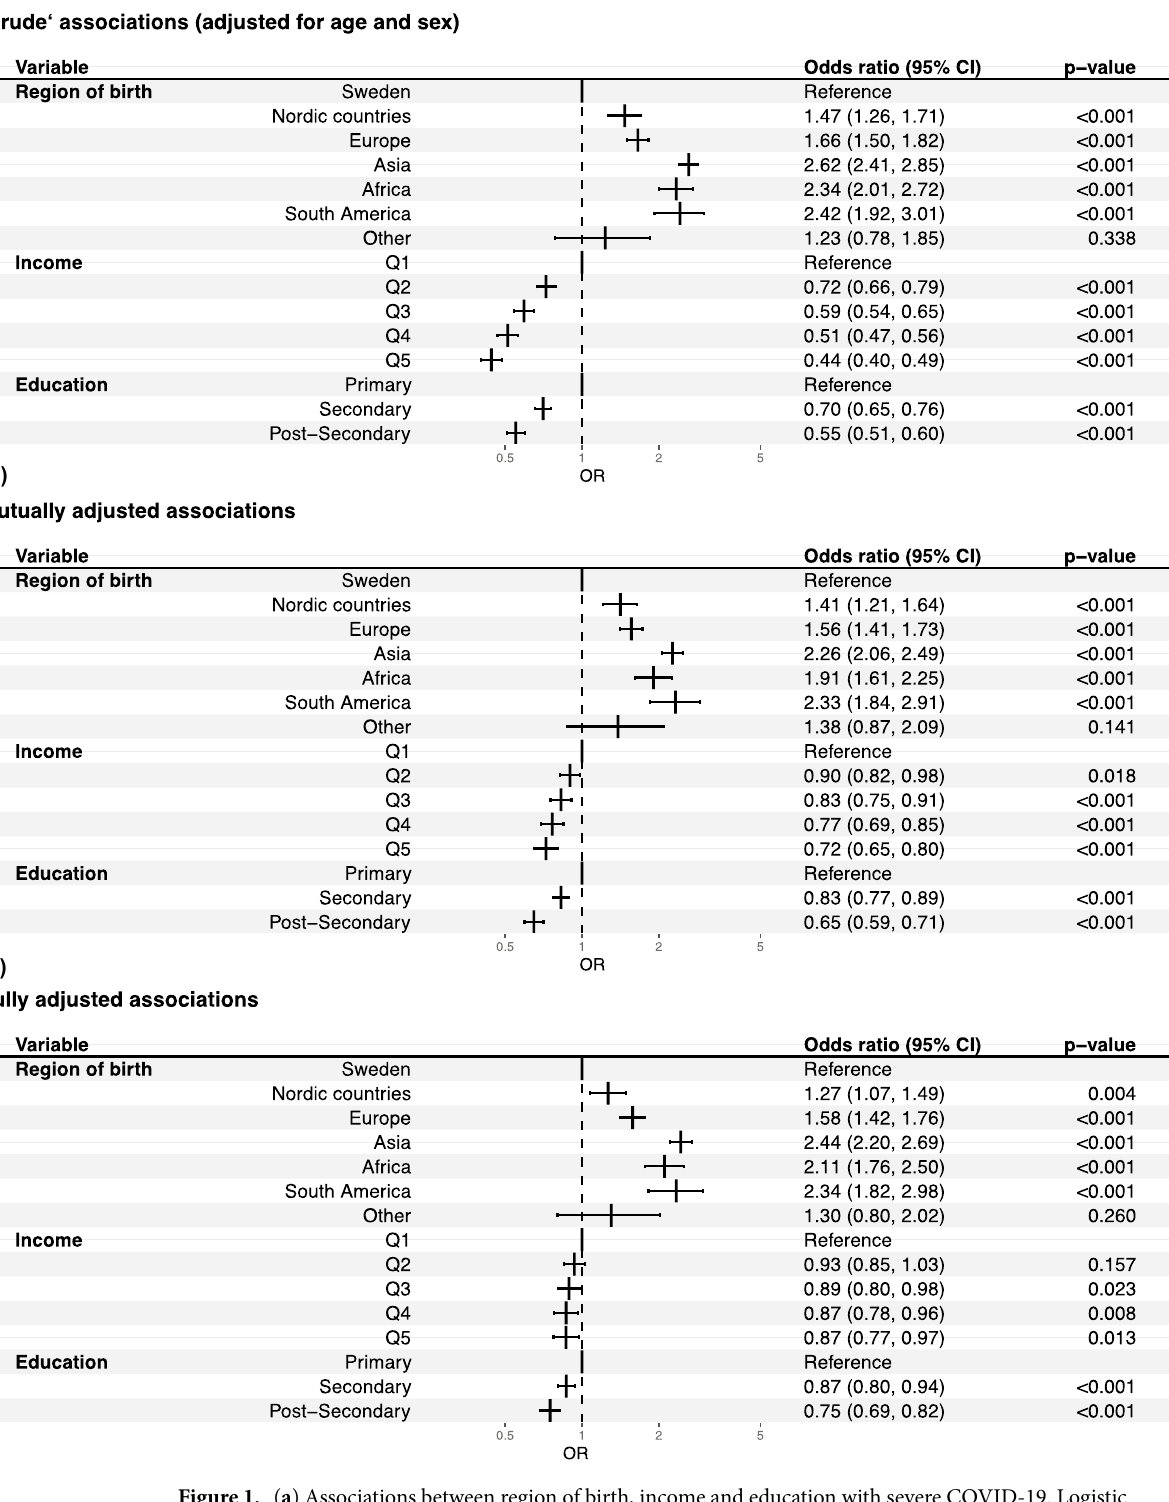
Figure 1. ( a ) Associations between region of birth, income and education with severe COVID-19. Logistic regression analyses. Crude = adjusted for age and sex. ( b ) Mutually adjusted = adjusted for region of birth, income, education age and sex. ( c ) Fully adjusted = Mutually adjusted + hypertension, diabetes (1 + 2), cardiovascular disease, atrial fibrillation, chronic kidney disease, heart failure, asthma, malignancy, obesity,